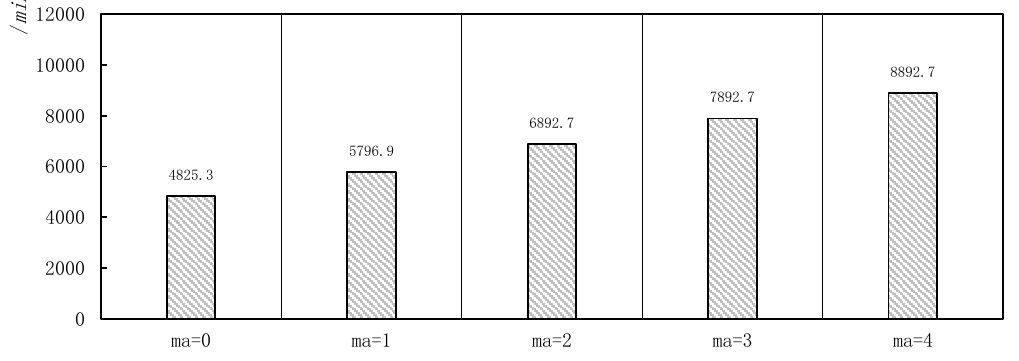
Figure 5. Comparison of the total trip time for various range anxiety levels.